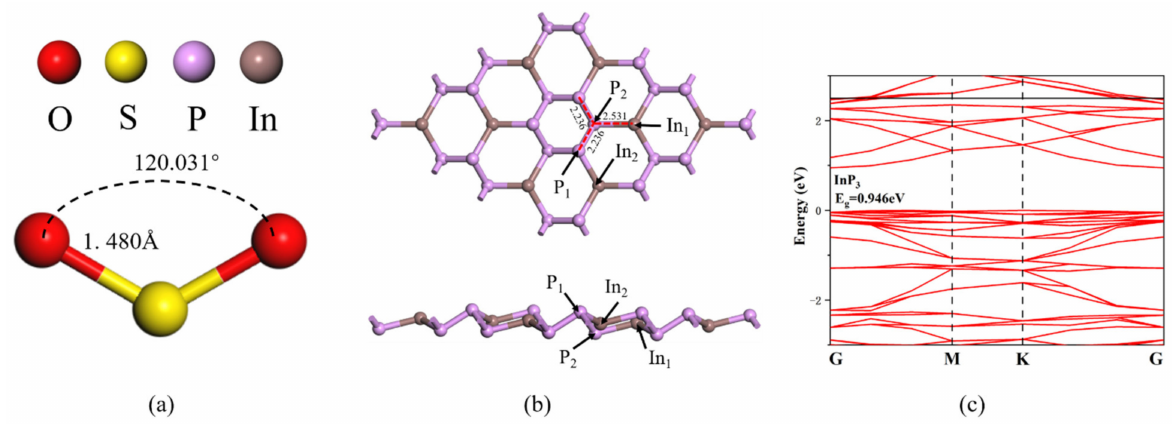
Figure 1. ( a ) Structure of SO 2 and ( b ) structure and ( c ) energy band of InP 3